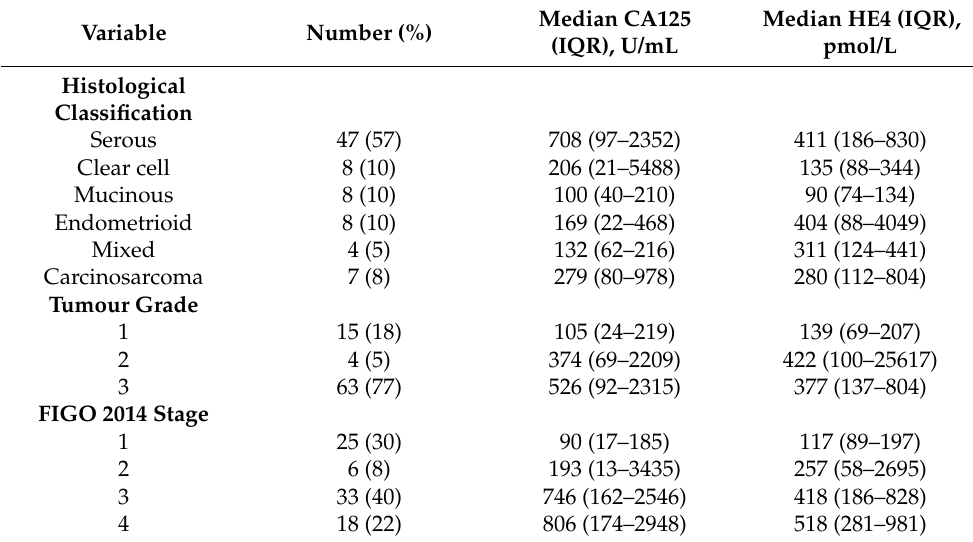
Table 2. Clinico-pathological features and serum results of ovarian cancer cases ( n =